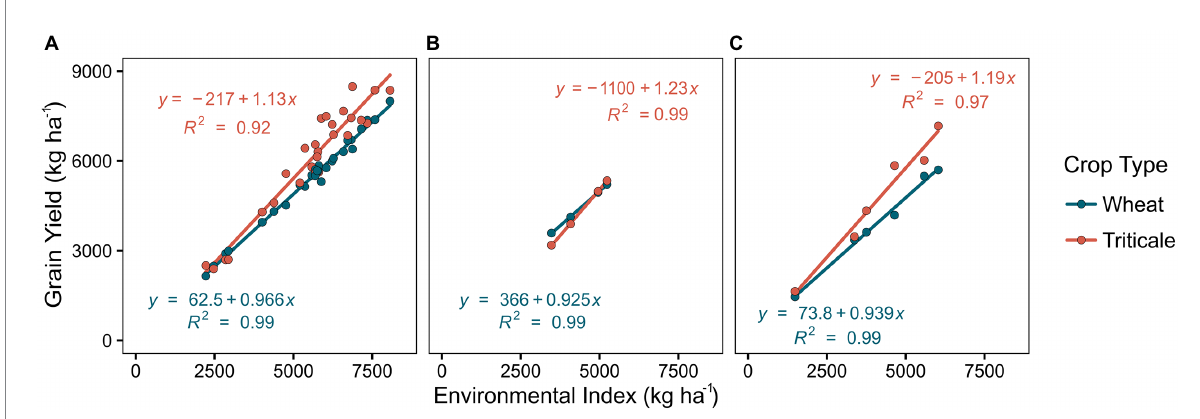
FIGURE 3 Relationship between yield and environmental index (EI) for wheat and triticale crop types under average growing conditions (A) , water-stress conditions (B) , and N-stress conditions (C) . The environmental index is the average yield of all varieties tested each site-year.